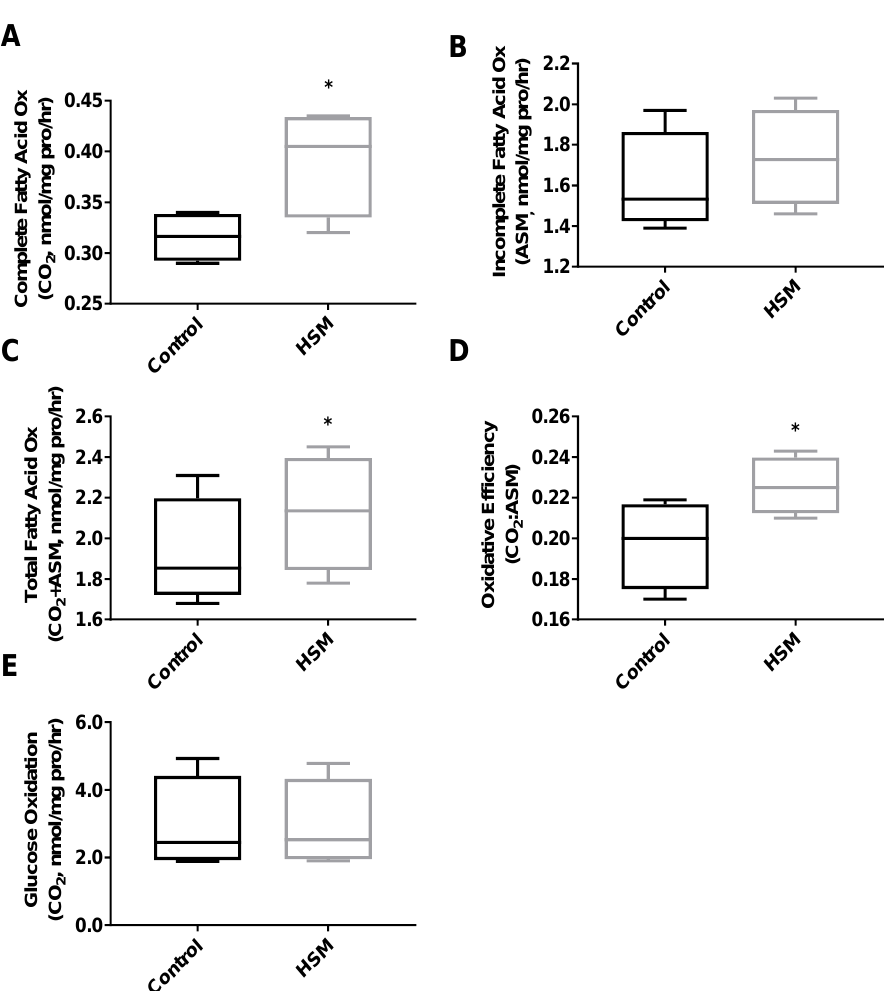
Figure 6. Complete ( A ), incomplete ( B ), and total ( C ) fatty-acid oxidation rates, as well as oxidative efficiency (complete/incomplete) ( D ) and glucose oxidation rates ( E ) of satellite cells (SC) from sedentary lean donors ( n = 6, BMI 18 – 25 kg/m+2+) exposed to 4 days of control (growth media) or high substrate media (HSM) (growth media +400 mM, 2:1, oleate – palmitate, +20 mM glucose) prior to 7 days of serum-starve (2% horse serum) differentiation. (*, **, *** indicating a p -value of <0.05, <0.01, <0.001, respectively).